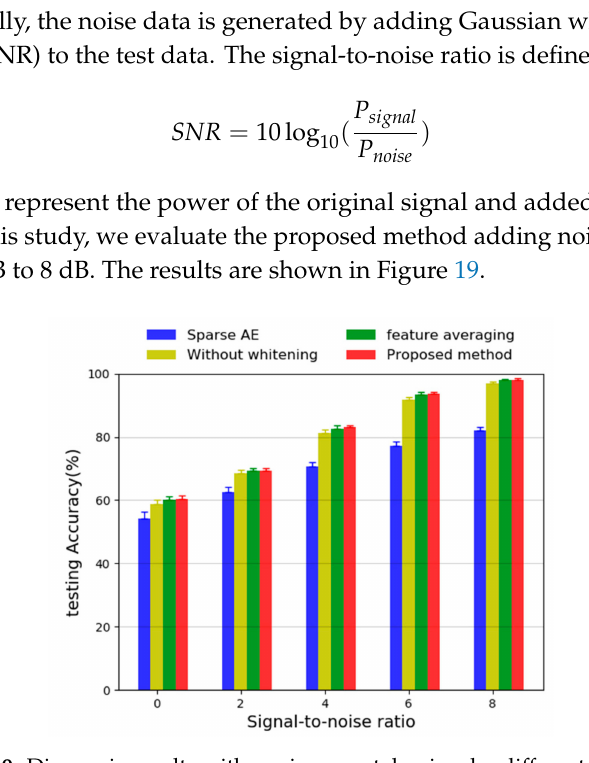
Figure 19. Diagnosis results with environmental noises by di ff erent